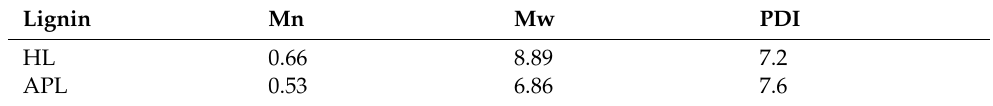
Table 1. Average molecular weights and polydispersity index (PDI) of the HL and APL in KDa. Lignin Mn Mw PDI HL 0.66 APL 0.53